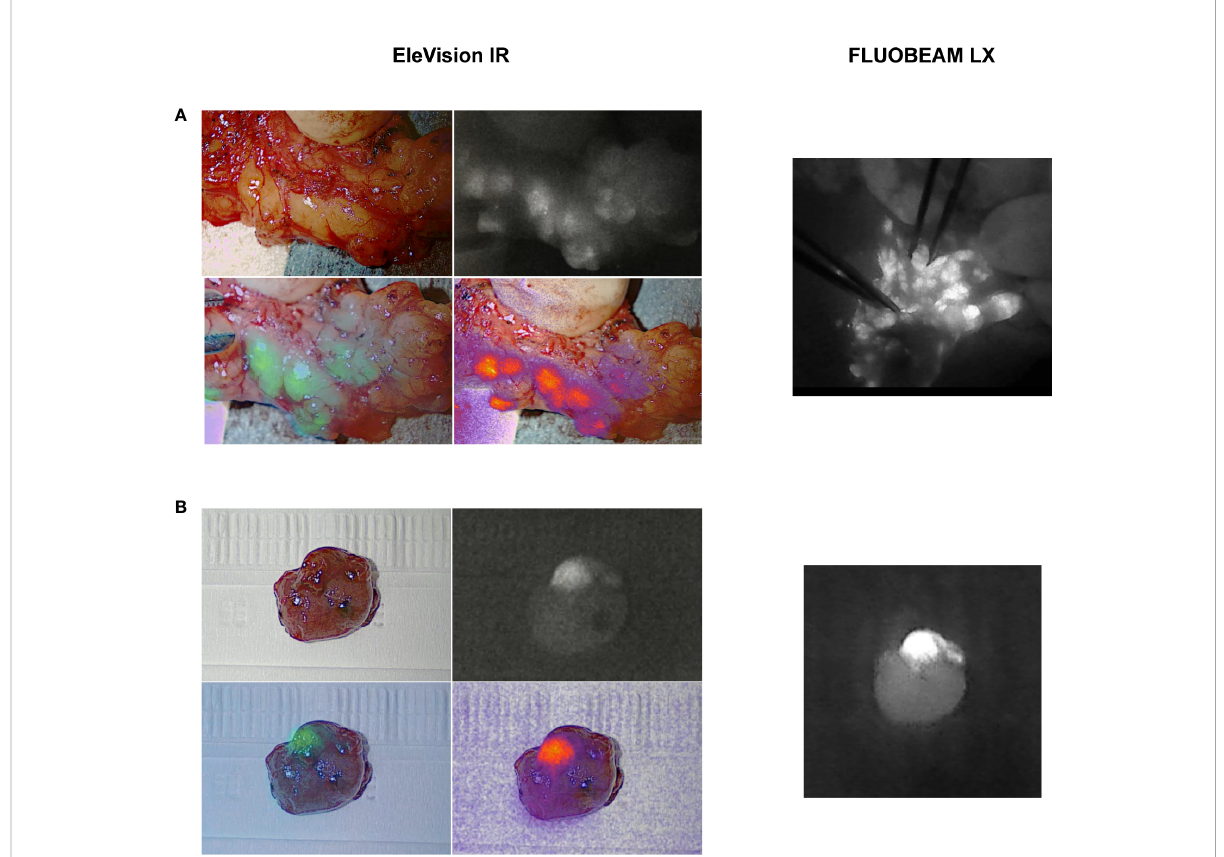
FIGURE 4 Comparison of images of ex vivo specimens generated with the EleVision IR and FLUOBEAM LX systems. (A) resected parathyroid adenoma; (B) pathological central lymph nodes in a lymphadenectomy specimen; The EleVision IR images in each panel are arranged as in Figure